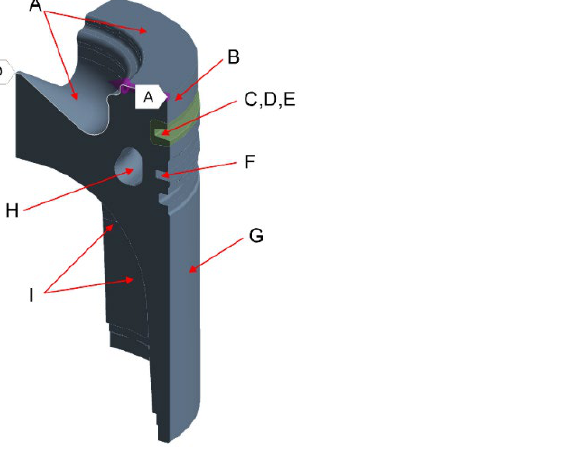
Figure 3. The simplified mode marked with path and boundary condition areas. Table 1. The name of each region.